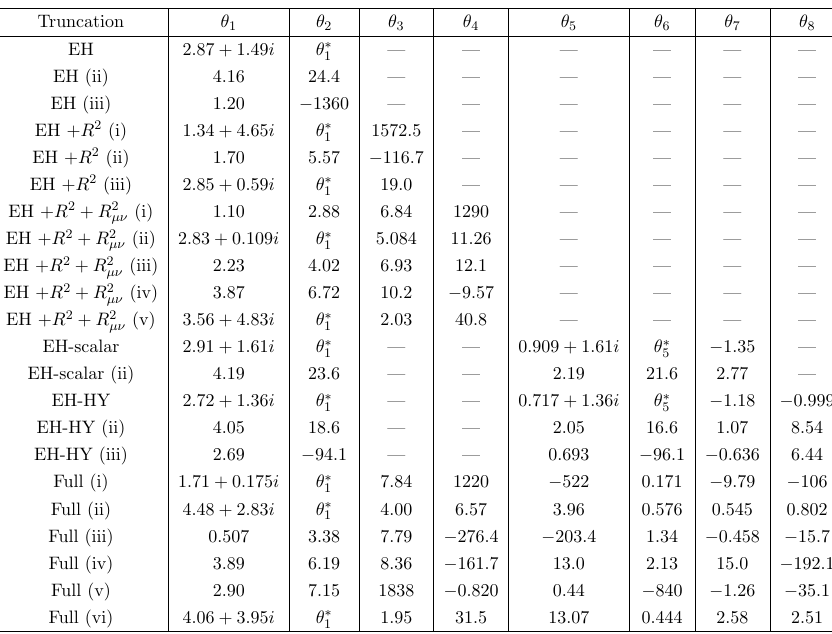
Table 10 . The values of critical exponents for (cid:11) = 0 and (cid:12) = (cid:0) 2.